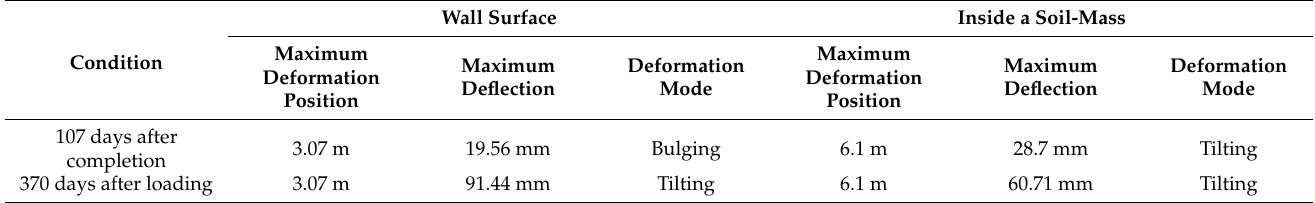
Table 1. Deformation after completion and